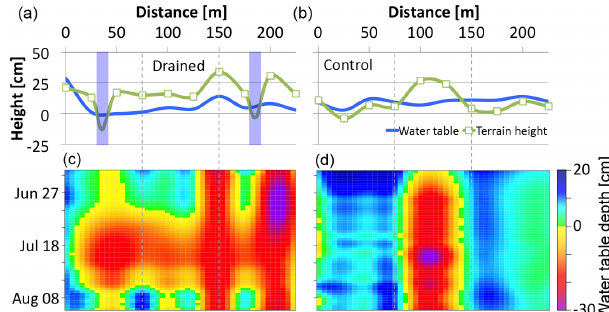
Figure 4. Variability of terrain height (green lines, boxes indicating micro-site study positions) and water table depth (blue lines) along transects in the drained (a) and control (b) sections of the obser- vation site (water table depth reflects conditions in mid-July 2014). Blue shading in drained panel indicates position of drainage chan- nel, where interpolation of terrain height was modified. The zero level was chosen arbitrarily, so absolute heights do not carry any in- formation in panels (a, b) . (c, d) Development of water table depth over time for the period 18 June to 14 August 2014 (interpolated over both space and time). Values are given relative to the surface, with negative values indicating water tables below the surface